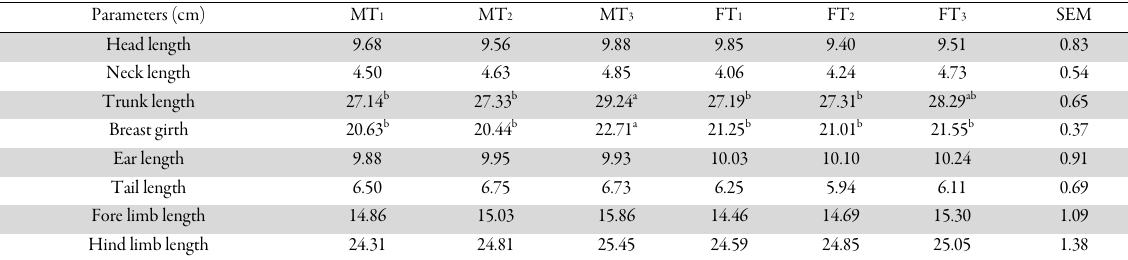
Table 3. Linear body measurements of growing rabbits administered Panax ginseng extracts Parameters (cm)